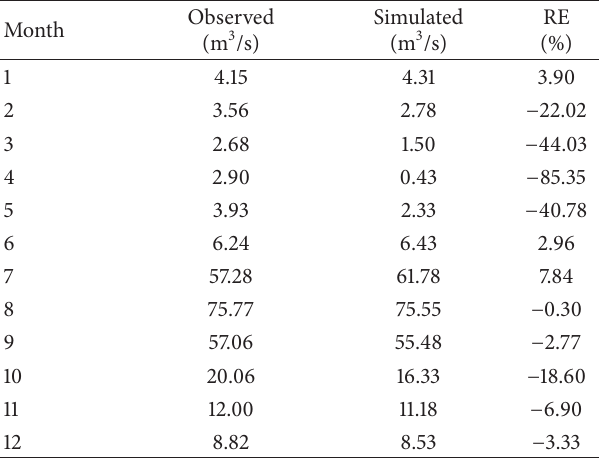
Table 5: Relative error analysis for monthly mean flow data in calibration period in the Jiaoyi watershed